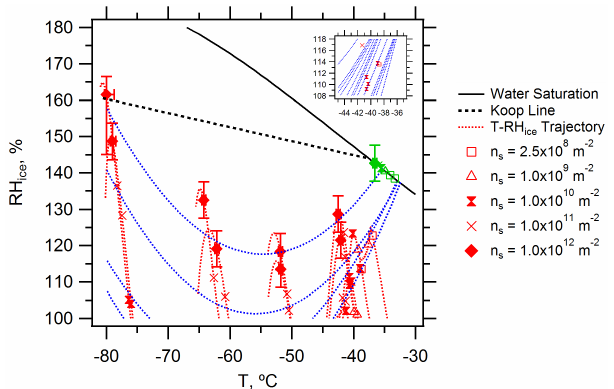
Figure 2. The constant n s magnitudes are joined by lines (blue) rep- resenting “isolines” of hematite freezing profiles in the T and RH ice space. The interpolated isolines are equally spaced at every order of magnitude from 10 12 m − 2 (top) to 10 9 m − 2 (bottom). Experimen- tal trajectories of AIDA expansion experiments with hematite par- ticles are shown as red dotted lines. The data indicated with green color on the water saturation line represent the previously reported results of immersion freezing (Hiranuma et al., 2014). The sub- panel shows a magnified section of T ( − 35 to − 45 ◦ C) and RH ice (110–120%) space with equidistant n s spacing (every quarter mag- nitude). The error bars at n s of 10 12 m − 2 are from